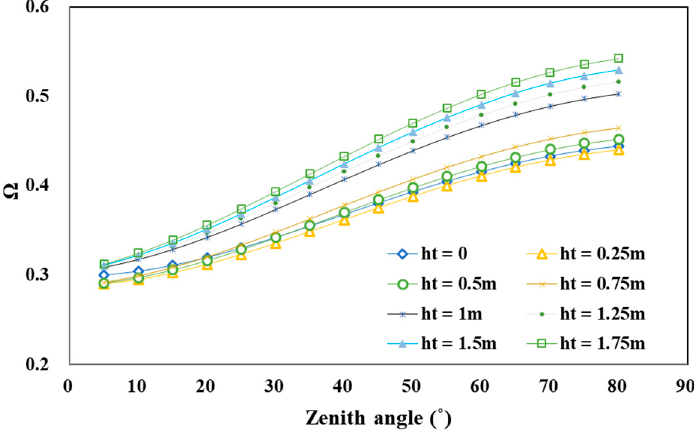
Figure 16. Clumping index variation with zenith angle for different tree distribution patterns. Simulation parameters as shown in Table 2, column 4.